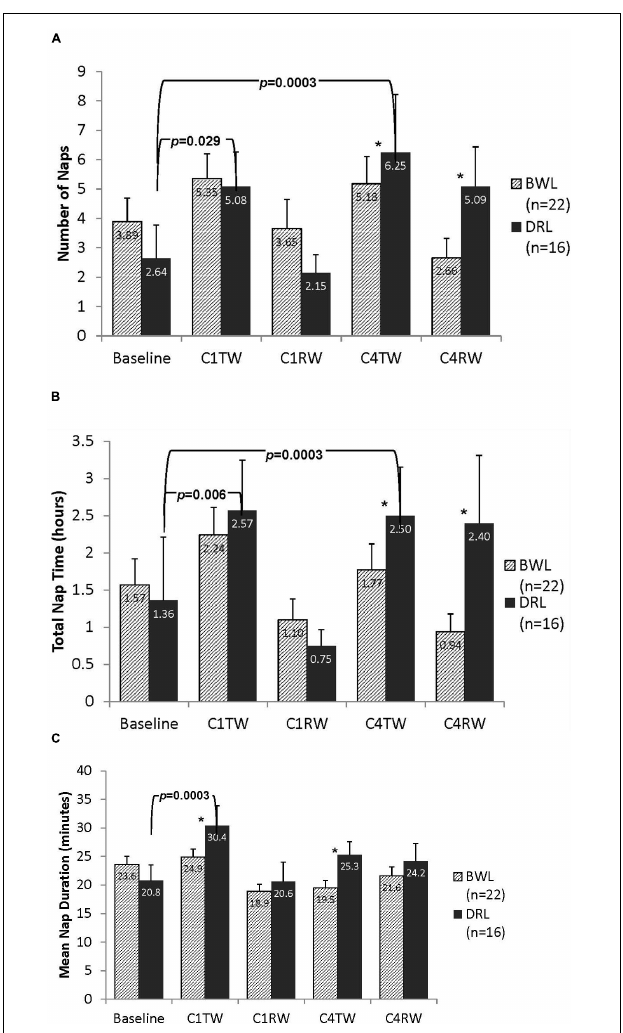
FIGURE 4 | Bar graphs depicting daytime (A) number of naps, (B) total nap time, and (C) mean nap duration for both BWL and DRL treatment groups from baseline through the TW and RW of chemotherapy cycles 1 and 4. With the exception of recovery weeks (C1RW and C4RW), the DRL group demonstrated more frequent (A) and longer (B) naps as chemotherapy treatment progressed. Mean nap duration (C) also increased at C1TW for the DRL group, * p < 0.05 for group-by-time interaction, indicating that compared to DRL group, BWL group had significant fewer naps and shorter total nap time during cycle 4 (both C4TW and C4RW).